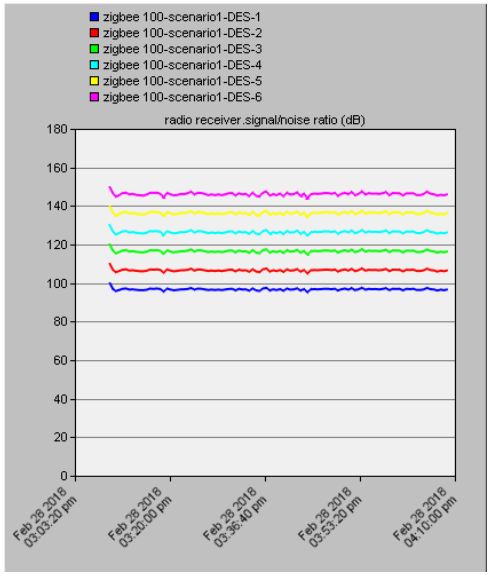
Figure 1. Fluctuations in Signal – Noise Ratio according to the changes in Transmitted Power. (X axis: Time, Y axis: Signal – Noise Ratio and Received Power).